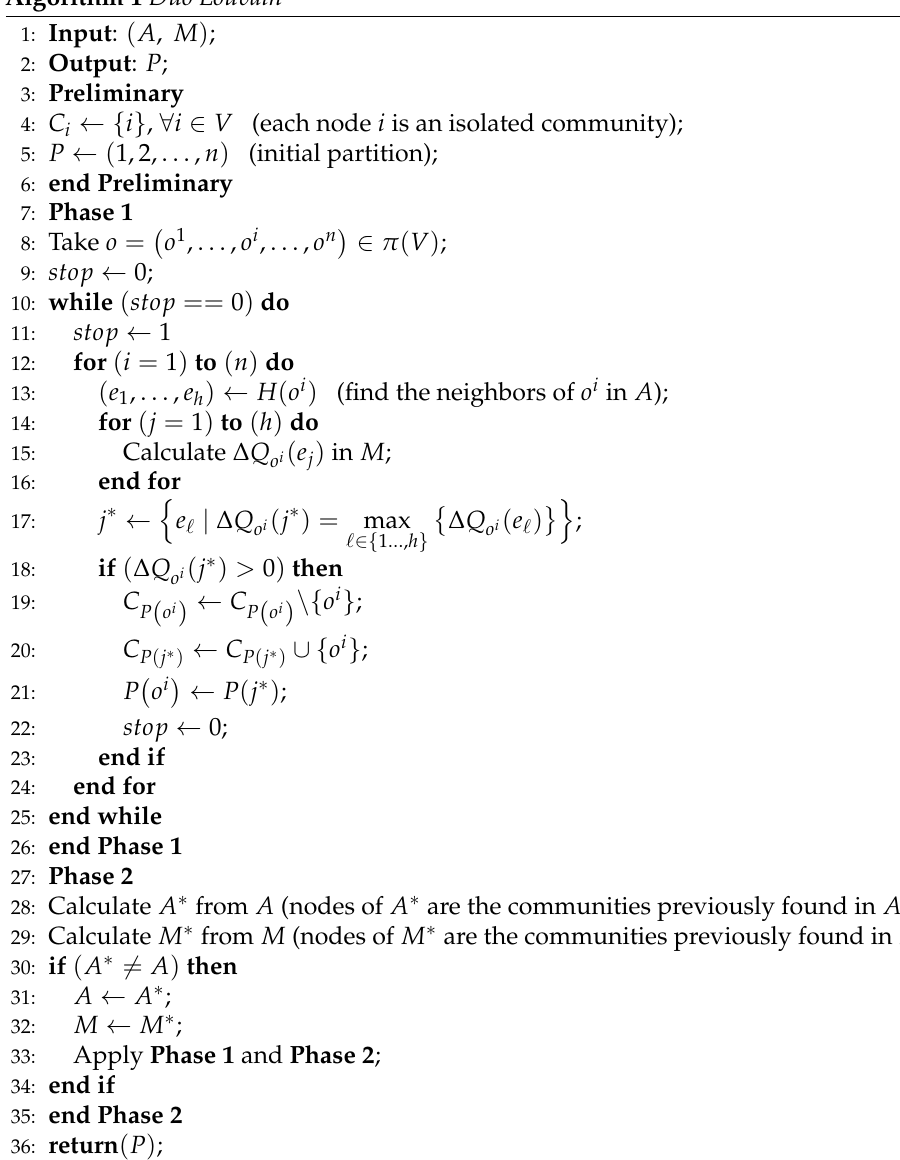
Algorithm 1 Duo